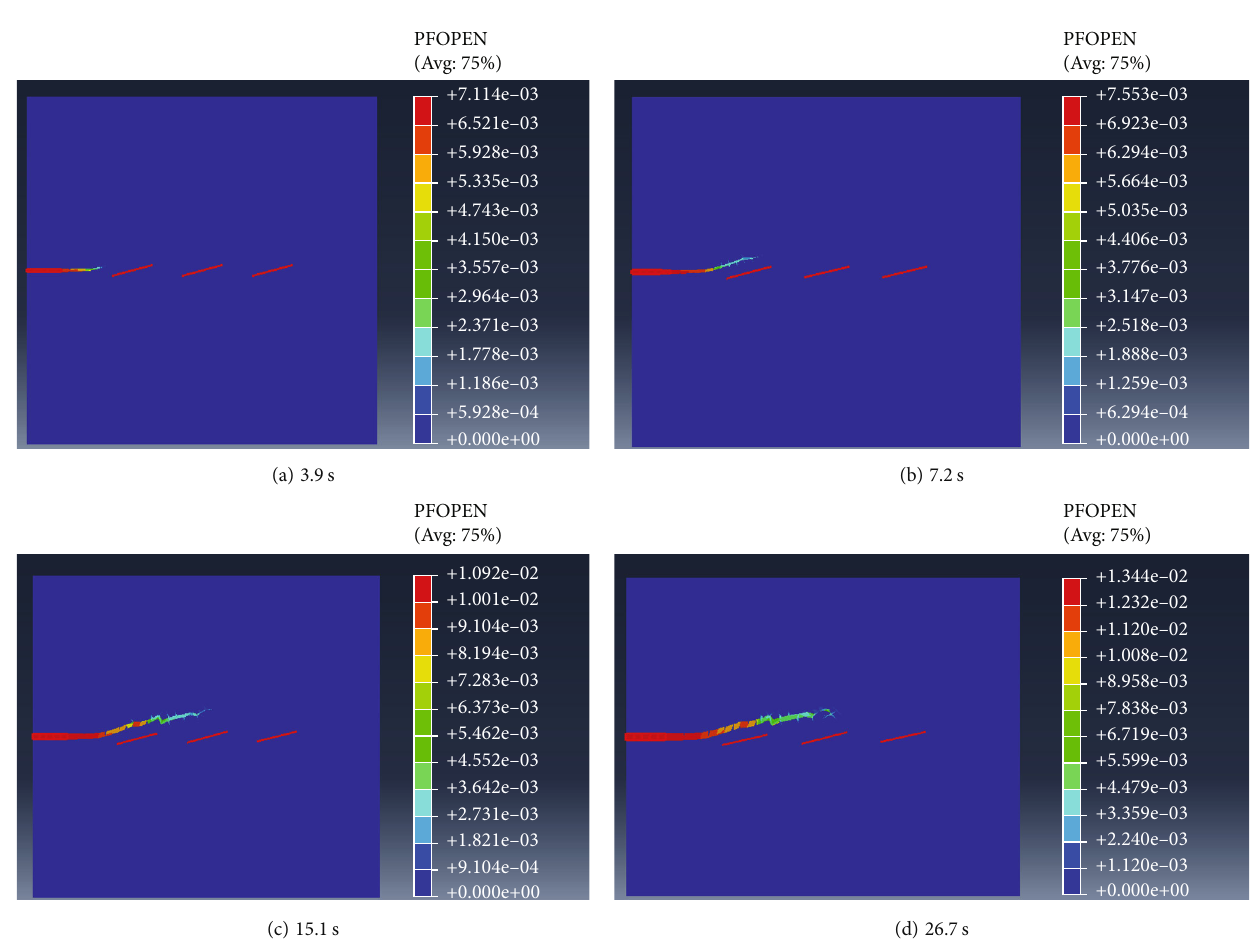
Figure 9: HF propagation at the NF approaching angle of 30 ° and stress anisotropy coe ffi cient of 0.3, where PFOPEN in the legend represents fracture opening.